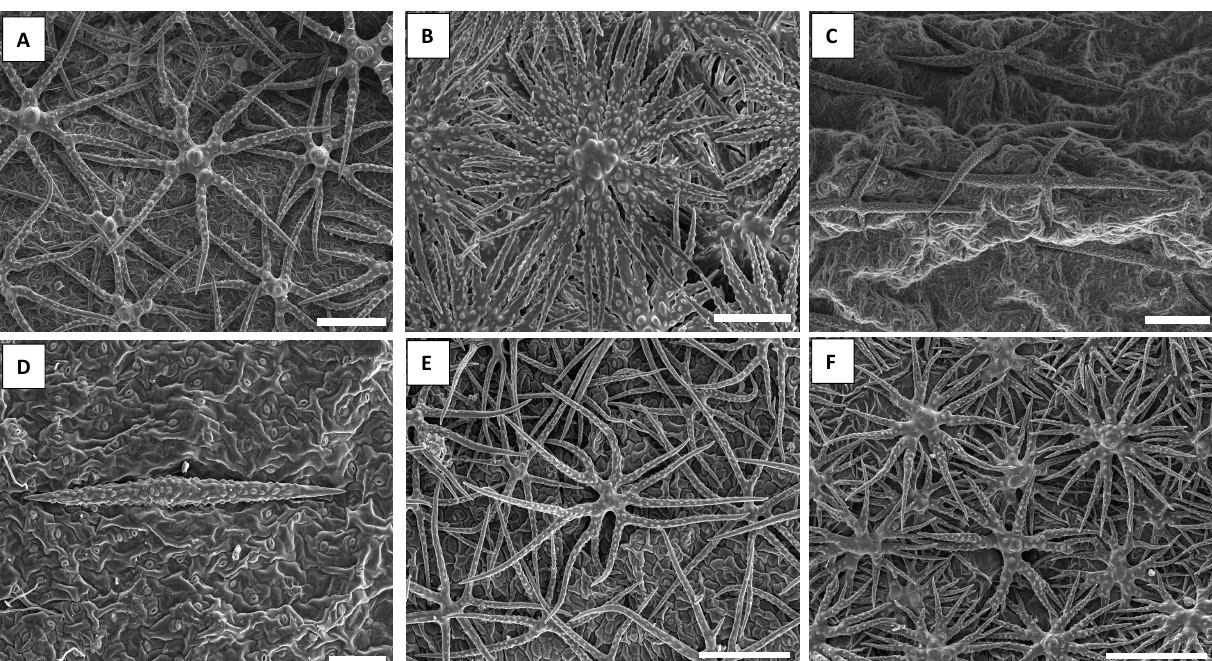
Figure 1. Secondary electron images showing the extent of trichome morphological diversity in Brassicaceae. ( A ). Odontarrhena corymbosoidea ( Selvi & Bettarini , FI-055806, FI); many branched (radiate-stellate) morphology. ( B ). Odontarrhena euboea ( Cecchi & Selvi , FI-058615, FI); complex higher order branching. ( C ). Bornmuellera baldaccii ( Selvi & Bettarini , FI-055815, FI); forked malpighiaceous trichome. ( D ). Bornmuellera emarginata ( Selvi & Bettarini , FI-055789, FI); stalkless T-shaped malpighiaceous trichome. ( E ). Odontarrhena chalcidica ( Selvi & Bettarini , FI-055792, FI); unicellular stellate trichomes. ( F ). Phylloloepidum cyclocarpum ( Cecchi & Selvi , Herb. FI-1362, FI); complex higher order branching. Scale bars: ( A , C , E , F ) = 200 μ m; ( B ) = 90 μ m; ( D ) = 100 μ m.